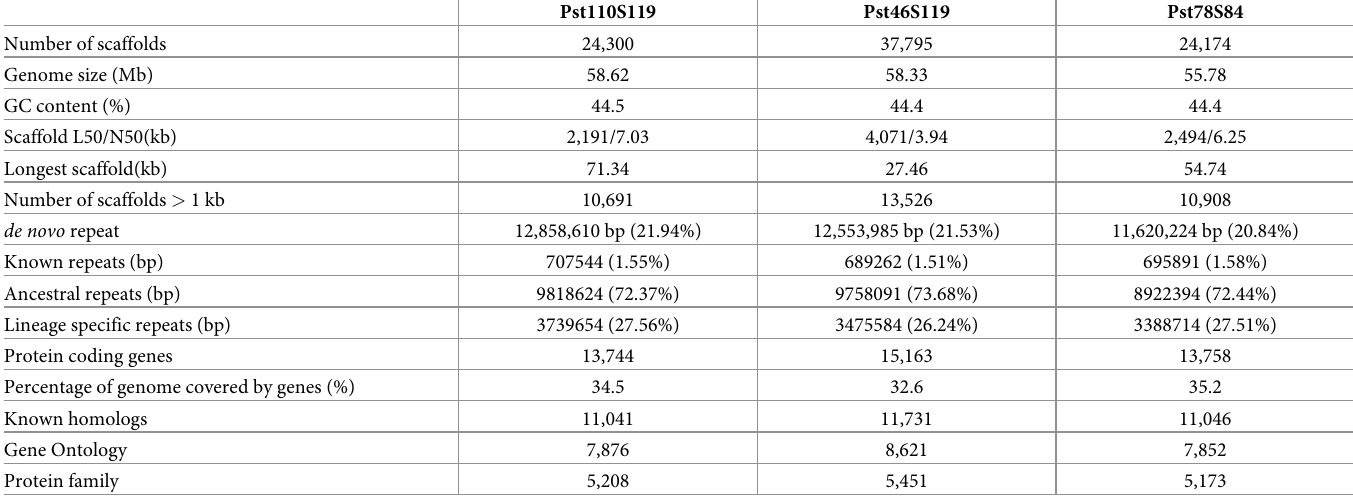
Table 2. Genome statistics of Puccinia striiformis tritici pathotypes Pst110S119, Pst46S119 and